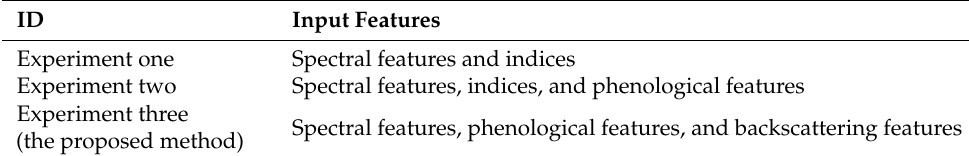
Table 2. Input features for the three